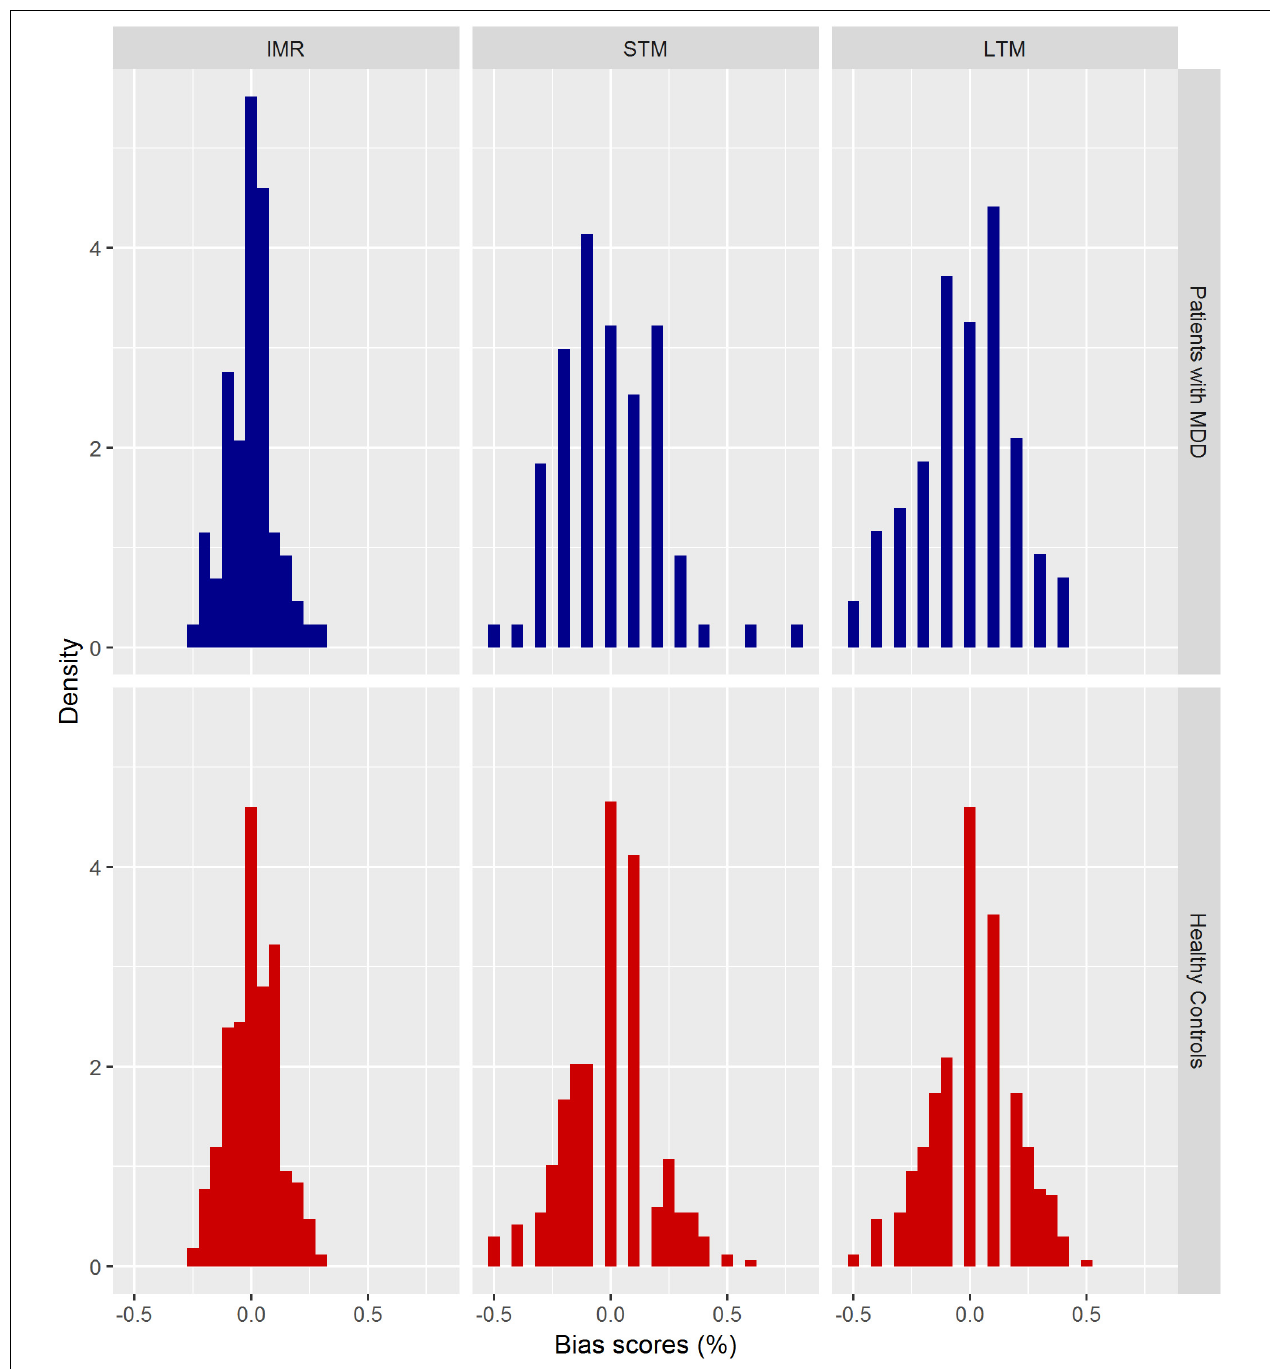
FIGURE 5 | Distribution of VAMT Bias scores (in percentage) for patients with MDD and healthy controls. Histograms of the distribution of VAMT Bias scores adjusted for age and sex. The y -axis (density) indicates to the relative frequency normalized such that the area covered by the bars of the histogram equals